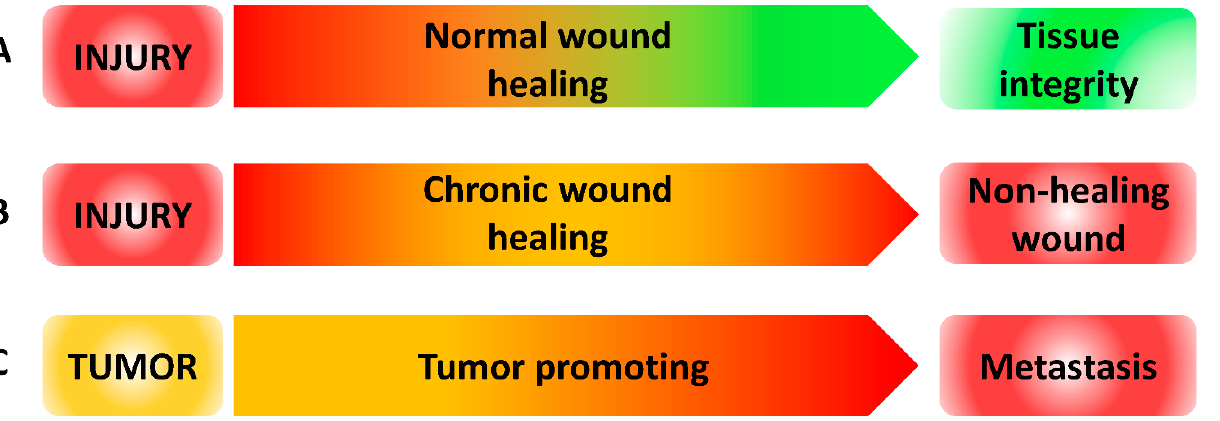
Figure 3. ROS levels during wound healing and metastasis. ( A ) ROS level during normal wound healing. After injury, high levels of ROS (red) are produced and then decreased to low level (green) over time to restore tissue integrity. ( B ) ROS level during chronic wound healing. After injury, high levels of ROS (red) are produced and failed to be reduced inducing non-healing wound. ( C ) ROS level during tumor progression. In tumor, ROS are produced in an intermediate level (orange). When ROS level increased, tumor progression is promoted leading to metastasis.